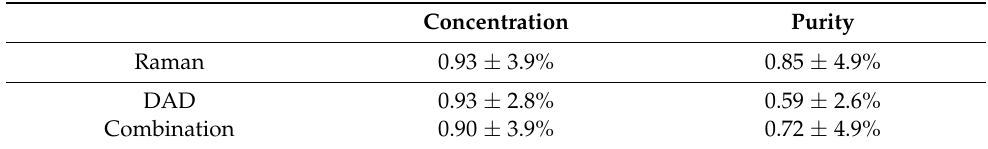
Table 1. PLS results of process analytical technology (PAT) feasibility study for Raman and DAD referring to mAb concentration and purity.